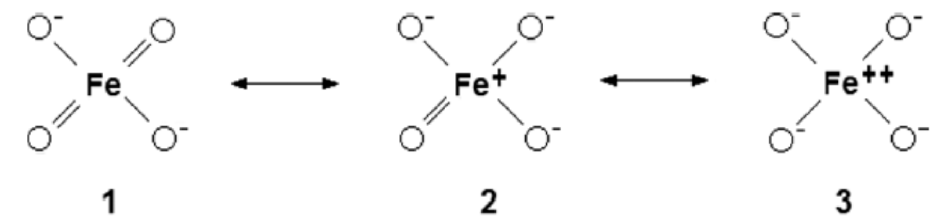
Figure 2. The resonance hybrids of the doubly negative-charged tetraoxoferrate(VI) ion [47]. Norcross et al. [47] then asserted that structure 3 (in Figure 2) is probably the most prominent, based on a theoretical study of tetrahedral, tetraoxo anions of the transition elements carried out by Ziegler et al. [48]. Employing the Hartree-Fock-Slater Discrete Variational Method, they predicted that the profile of the d-orbital populace, regardless of d 0 , d 1 or d 2 , will be very similar to those of the corresponding divalent cation M 2+ in which two electrons have been ejected from the ( n + 1)s orbital of M, the metallic element. Although Ziegler et al. [48] did not involve [FeO 4 ] 2 − specifically in their analysis (the tetra- oxo moieties examined were [MnO 4 ] − , [MnO 4 ] 2 − , [MnO 4 ] 3 − , [CrO 4 ] 2 − , [CrO 4 ] 3 − , [VO 4 ] 3 − , RuO 4 , [RuO 4 ] − , [RuO 4 ] 2 − , [TcO 4 ] − and [MoO 4 ] 2 − ), their argument is so convincing that the generalization made it possible for Norcross et al. [47] to favour structure 3 as the most significant, as far as redox reactions are concerned. In 1994, Jitsuhiro et al. chose the Symmetry Adapted Cluster (SAC) and the SAC-configuration interaction (SAC-CI) theories as tools for their analysis of the [CrO 4 ] 2 − ion in the ground and excited states [49]. The analysis resulted in the positive charge of the central metal ion taking on values between 1.04 and 1.44, prompting Norcross et al. [47] to favour both structures 2 and 3 as candidates over structure 1 in Figure 2. The Hartree-Fock-Slater Discrete Variational Method, SAC and SAC-CI theories mentioned immediately above could have been applied to analyse [FeO 4 ] 2 − in its ground and excited states with an aim of gaining the same insights into structure and bonding. After all, laboratory preparations of metal ferrate(VI) both as literature since the 1950s. The canonical structures in Figure 2 (adapted from [47]) never went out of fashion amongst authors. For example, Ghernaout & Naceur [50] used the same diagram to illustrate the nature of bonding in [Fe VI O 4 ] 2 − while reviewing its many before reviewing all the methods for the production of ferrate(VI)